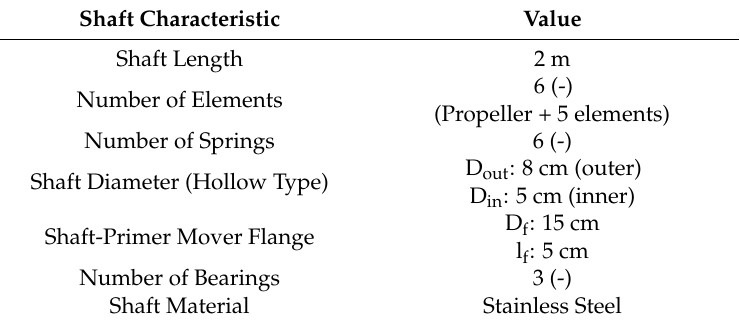
Figure 13. Inputs (left) and outputs (right) for the block. Implementing the shafting vibrational model in MATLAB/Simulink.